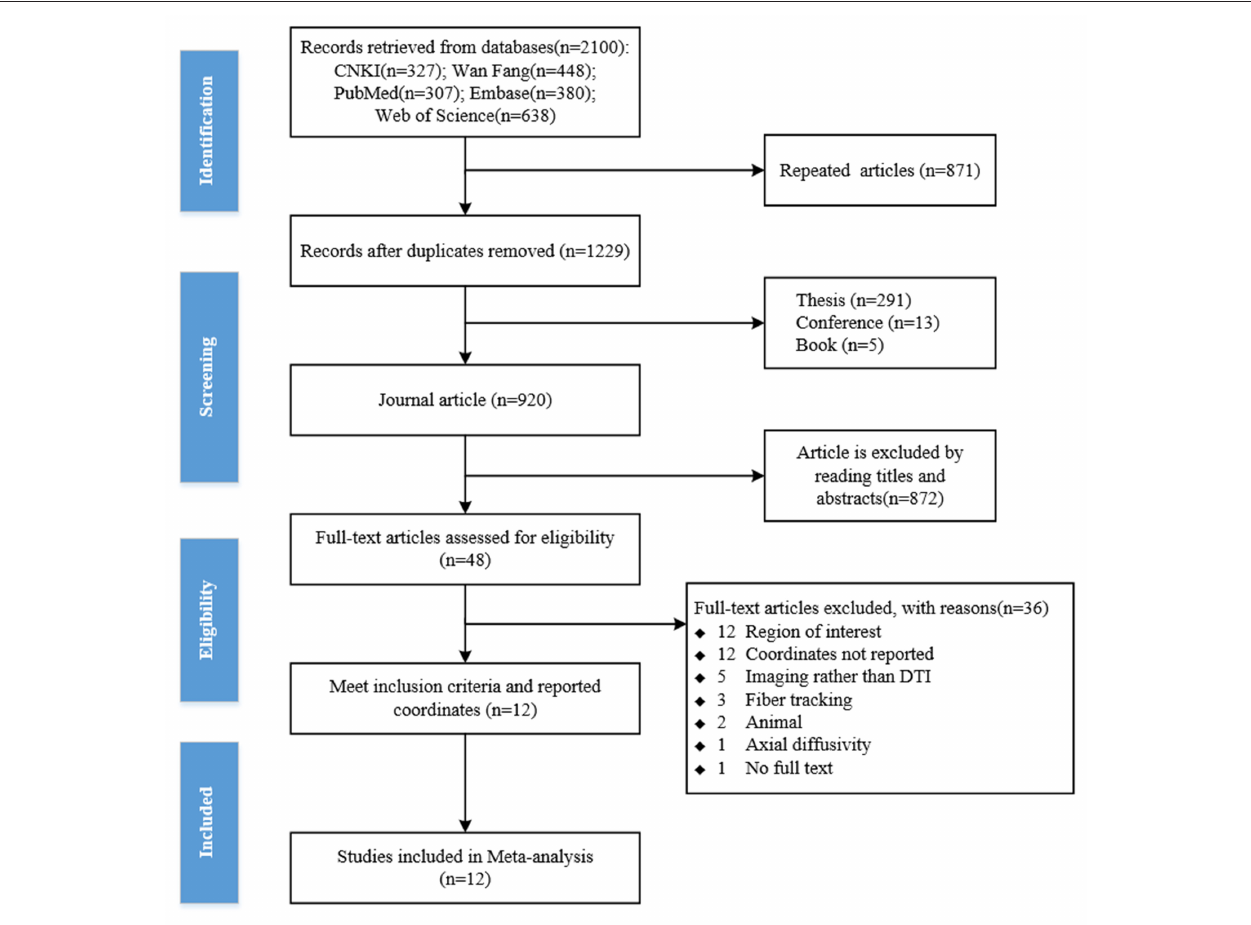
FIGURE 1 | The flowchart of the literature